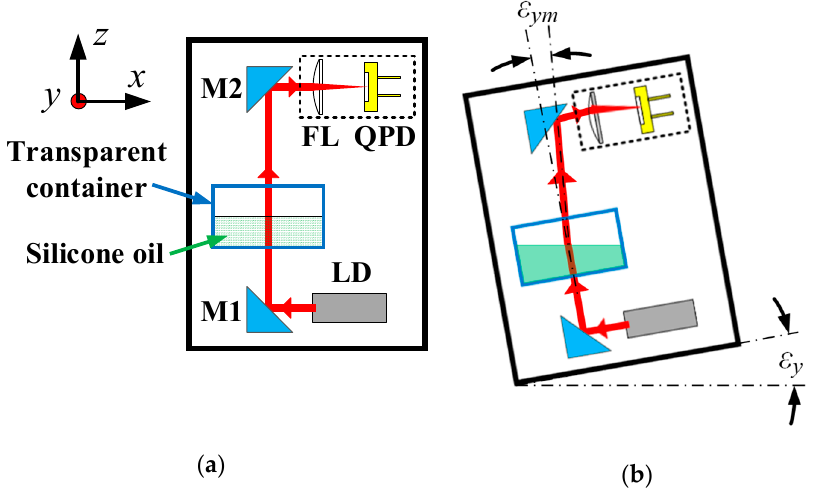
Figure 1. Schematic diagram of the dual-axis precision level: ( a ) optical configuration; ( b ) measurement principle.